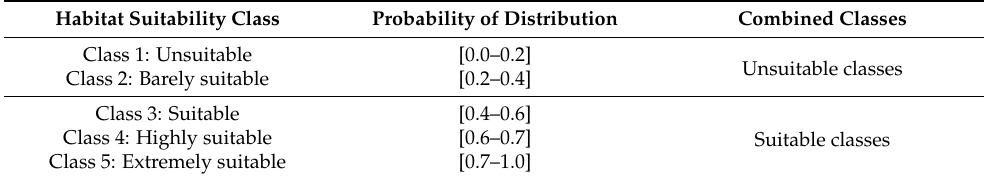
Table 2. Classes of habitat suitability used to identify the potential and future species’ probability of distribution, based on the recommendations of Yi et al. [3].